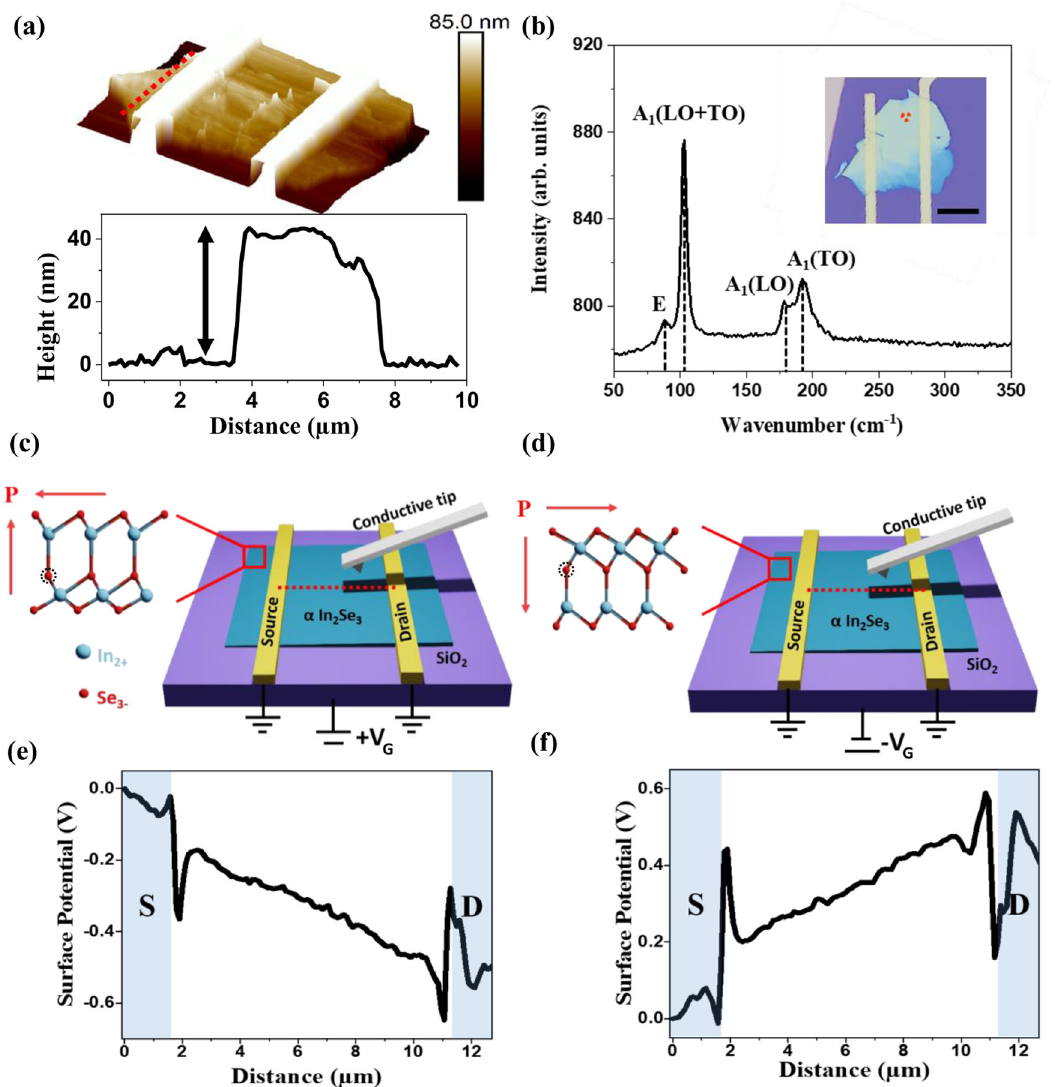
Fig. 1 Characterization of α -In 2 Se 3 based fi eld-effect transistors. a top — AFM topography of α -In 2 Se 3 fl ake on a Si/SiO 2 substrate with Cr/Au electrodes deposited by e-beam lithography, bottom — Height pro fi le of the fl ake along the red dotted line shows the height to be ~40 nm, b Raman spectra of α -In 2 Se 3 fl ake with prominent peaks at 89, 104, 178, and 192 cm − 1 ; inset shows the optical image of the fl ake and the red dot denotes the point of the Raman measurement. Scale bar is 10 µm. Schematic of the KPFM experimental setup for positive ( c ) and negative ( d ) applied back gate voltage bias with source and drain grounded. The insets illustrate the respective crystal structures for the alternating bias conditions with intercoupled IP and OOP polarizations in the sample (the directions of which are marked by the red arrows). Measured surface potential along the α -In 2 Se 3 channel for ( e ) positive and ( f ) negative applied gate